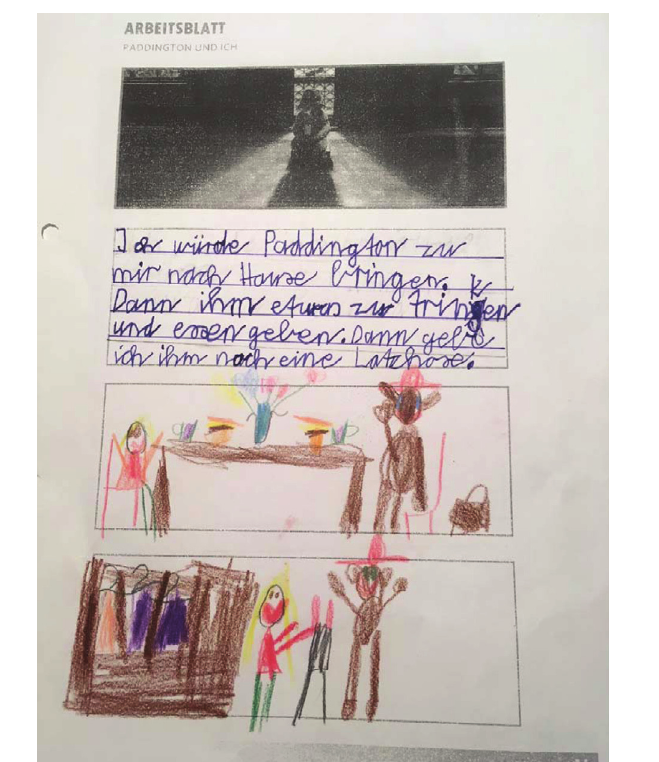
Figure 5: A primary school student from the south of Germany wrote: ‘I would bring Paddington to my home. Then I give him something to drink and eat. Then I give him flap